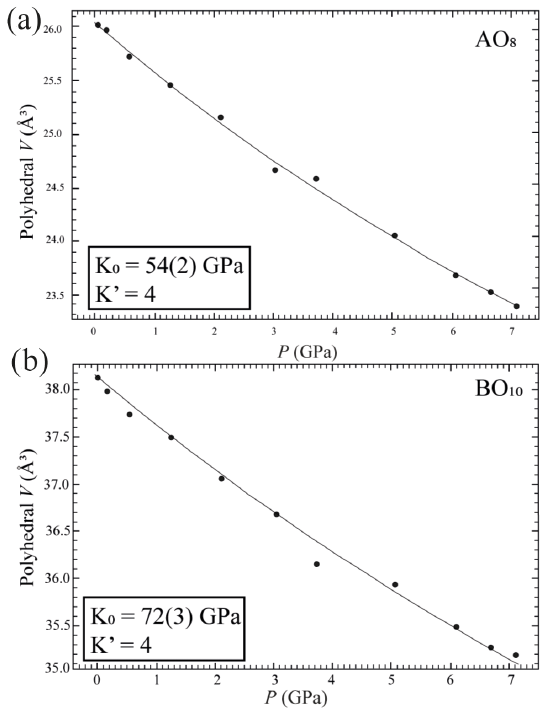
Figure 5. Pressure-induced evolution of AO 8 (a) and BO 10 (b) polyhedra in the crystal structure of burbankite. The solid black line represents a BM2-EoS fit to the data.